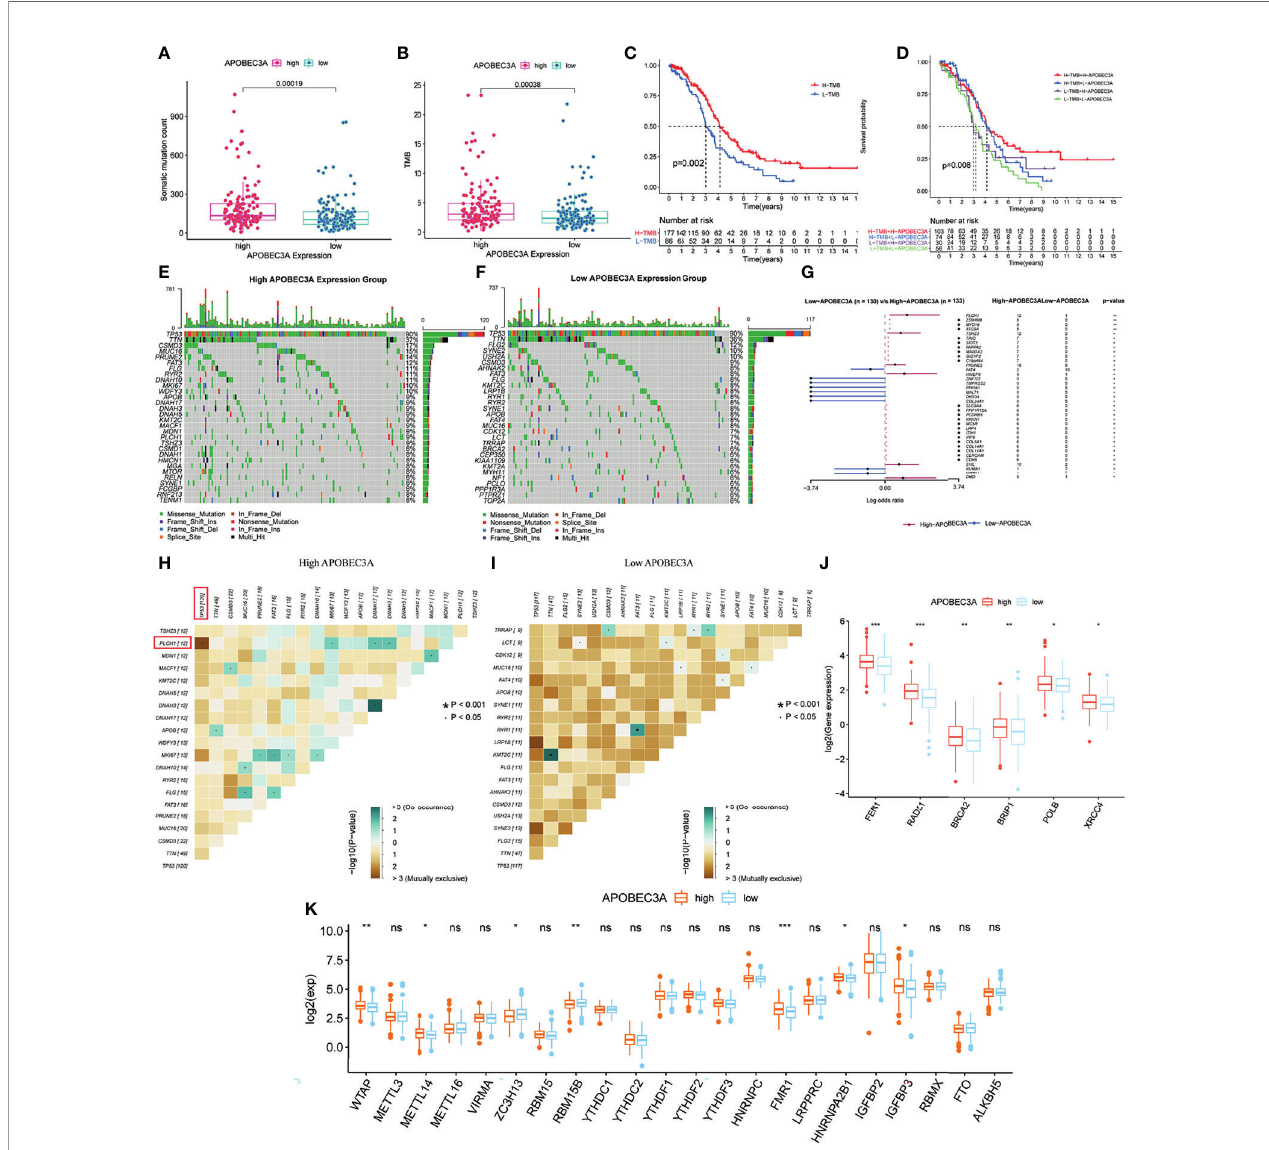
FIGURE 7 | Mutation analysis of APOBEC3A high- and low-expression cohorts in ovarian cancer (OC) patients. (A) The correlation of APOBEC3A with somatic mutation count, Wilcoxon rank sum was applied for the signi fi cance test. (B) The correlation of APOBEC3A with tumor mutation burden (TMB). (C) Survival analysis for OC patients with high- and low-TMB groups. Patients were marked with high TMB or low TMB depending on comparing with the median TMB level. p = 0.002 by log-rank test. (D) Kaplan – Meier curve analysis of overall survival is shown for patients classi fi ed according to TMB and APOBEC3A expression. Statistical analysis was performed using the log-rank test. (E, F) Waterfall plot shows the mutation distribution of the top 30 most frequently mutated genes. The central panel shows the types of mutations in each OC sample. The upper panel shows the mutation frequency of each OC sample. The bar plots on the left and right side show the frequency and mutation type of genes mutated in the low-APOBEC3A (E) and high-APOBEC3A (F) cohorts, respectively. The bottom panel is the legend for mutation types. (G) Forest plot and waterfall plot display the signi fi cantly differentially mutated genes between APOBEC3A high- and low-expression cohorts. ** p < 0.01, * p < 0.05. (H, I) The heatmap illustrates the mutually co-occurring and exclusive mutations of the top 20 frequently mutated genes. The color and symbol in each cell represent the statistical signi fi cance of the exclusivity or co-occurrence for each pair of genes. TP53 and PLCH1 are marked out in the red rectangle. (J) The correlation of APOBEC3A with DNA damage response (DDR) genes. *** p < 0.001, ** p < 0.01, * p < 0.05. (K) The correlation of APOBEC3A with m6A regulators. *** p < 0.001, ** p < 0.01, * p < 0.05, ns, not signi fi